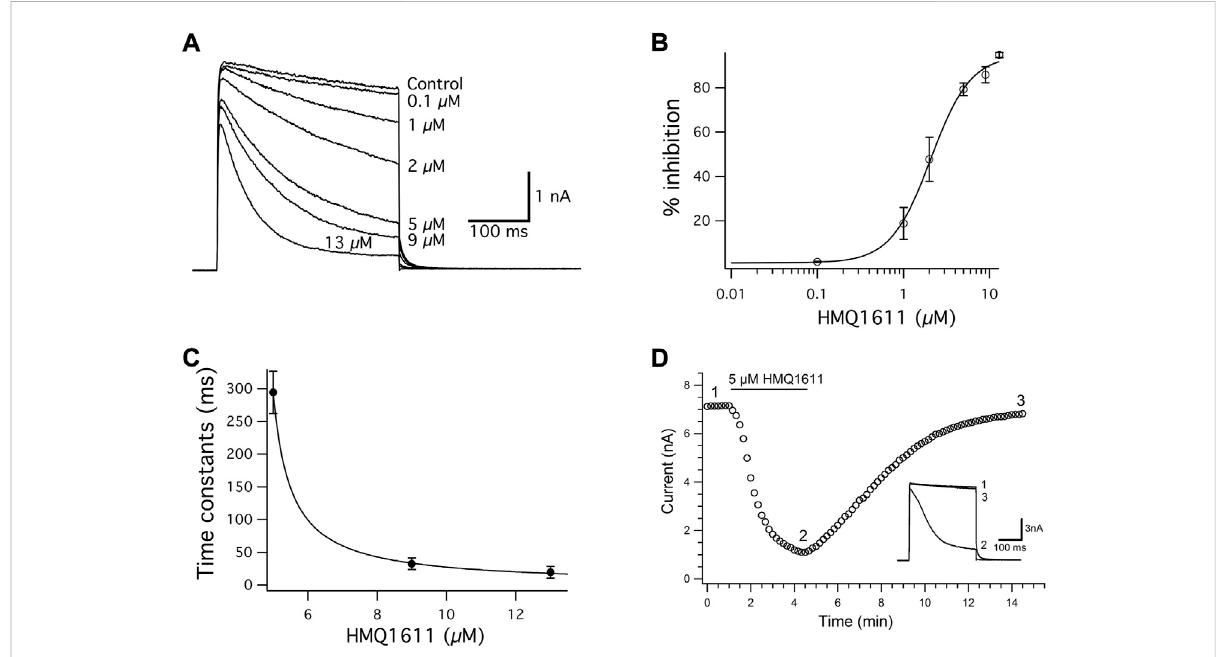
FIGURE 2 Concentration-dependent block of hKv1.5 current by HMQ1611. (A) Superimposed hKv1.5 current traces were elicited by applying 300 ms depolarizing pulses from a holding potential of -80 mV to +30 mV every 10 s in the absence (control) and presence of various concentrations of HMQ1611(0.1,1, 2, 5, 9, and 13 μ M). (B) Concentration – response relationship for theinhibition ofhKv1.5 current byHMQ1611. Percentage inhibition (% inhibition) represents the fraction of hKv1.5 current reduced by each concentration of HMQ1611 with reference to the control amplitude, measured at the end of 300 ms depolarizing pulse to +30 mV. The smooth curve through the data points represents a least-squares fi t of a Hill equation,yieldinganIC 50 of2.07±0.21 μ MandaHillcoef fi cient(n H )of1.87±0.32( n =7). (C) KineticsofHMQ1611blockofhKv1.5current.Thetime constant ( τ D ) for tail current during the depolarization potential of +30 mV at various concentrations of HMQ1611 was plotted as a function of the drug concentration (1, 9, and 11 μ M).The solidline represents the fi tof thedata to thehyperbolicfunction. (D) Reversible inhibition ofhKv1.5 current by 5 μ M HMQ1611. The current amplitude of hKv1.5 were measured at the end of 300 ms depolarizing step from a holding potential of -80 mV to +30 mV every 10 s, before (control), in the presence of 5 μ M HMQ1611, and after its washout. Inset shows the current trace, which was recorded at different time